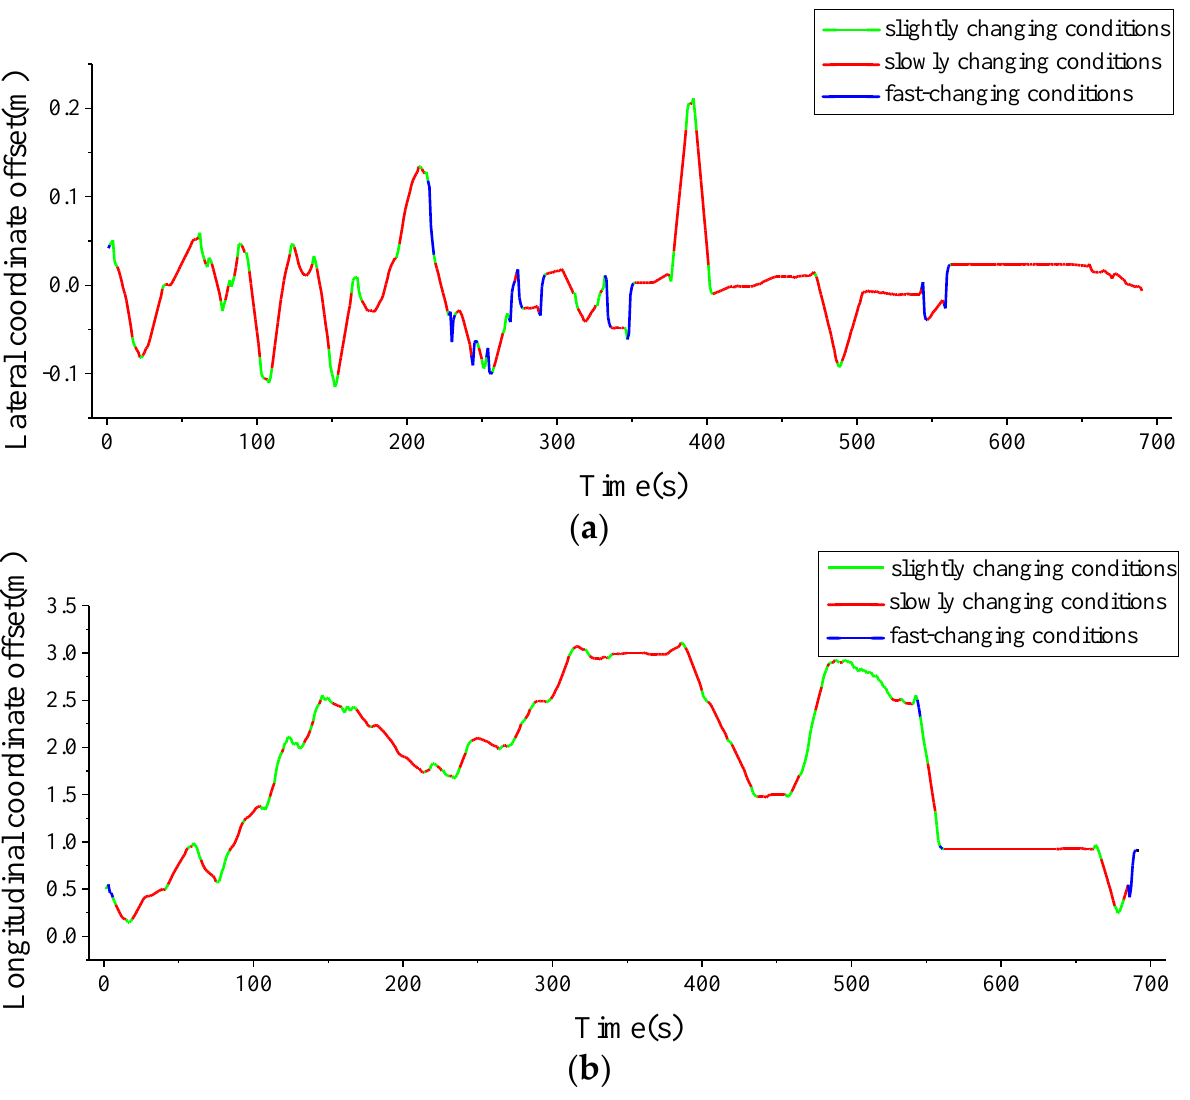
Figure 4. Driving Intention Classification Results: ( a ) Lateral Driving Intention Classification Results; ( b ) Longitudinal Driving Intention Classification Results.